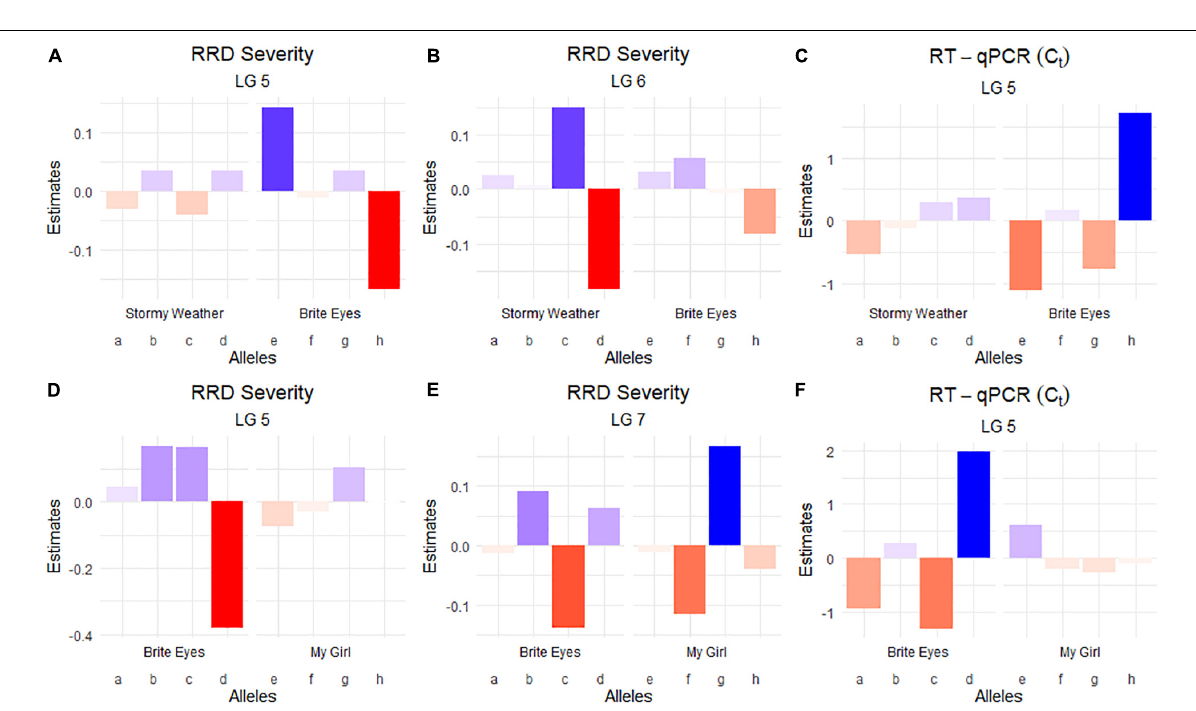
Frontiers in Plant Science |